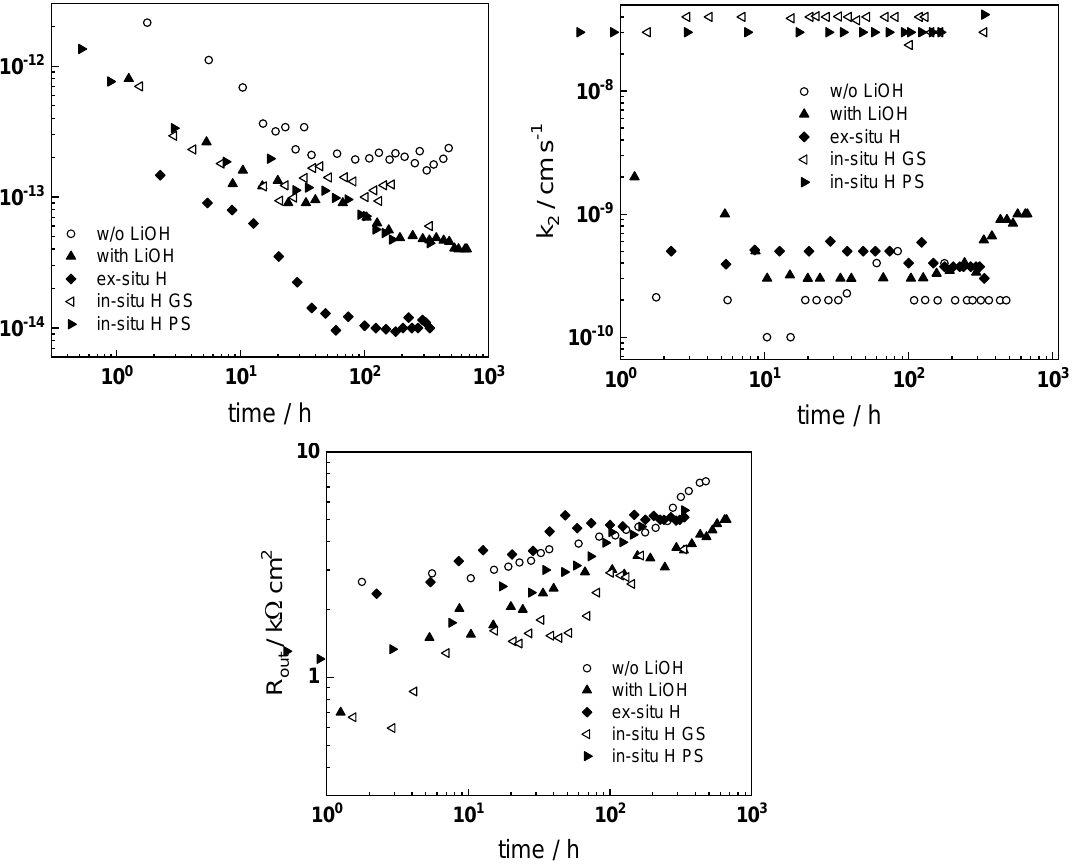
Figure 10. Parameters of interfacial reactions as a function of time and oxidation conditions.